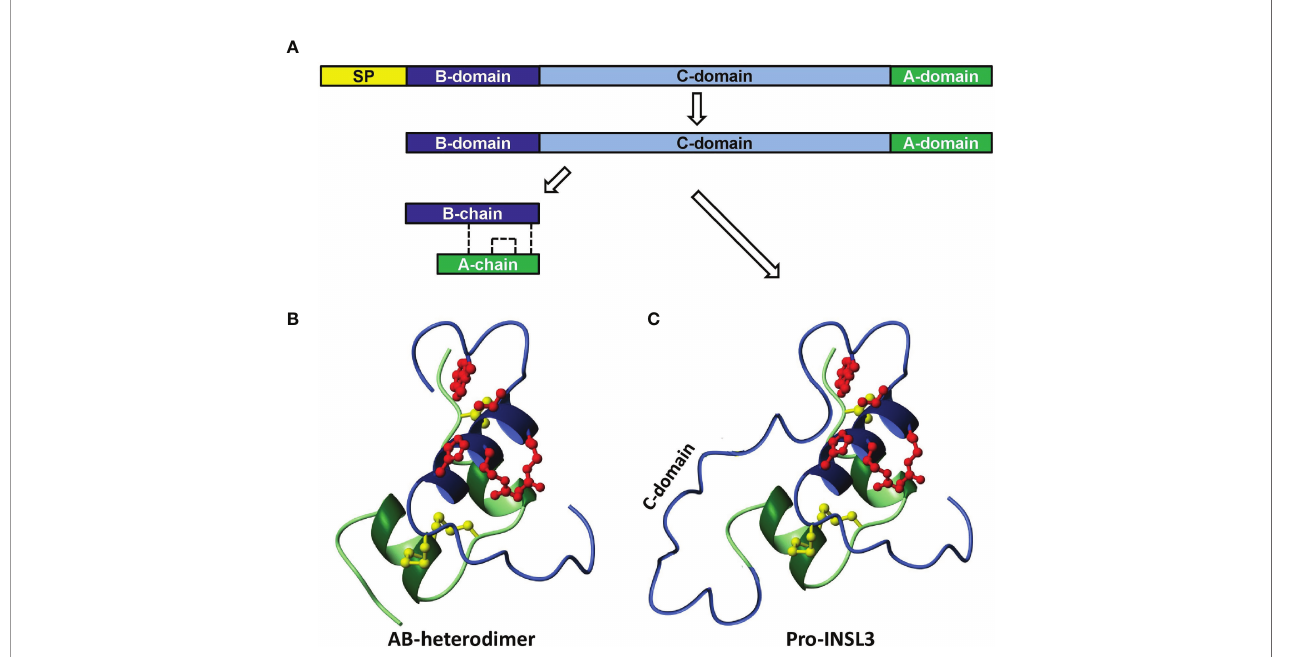
FIGURE 1 | Scheme to illustrate the synthesis and processing of INSL3 from its preliminary precursor form (A , prepro-INSL3 ) via a possibly secreted pro-form (A, C , pro-INSL3 ) , to give rise to the fi nal A-B heterodimer (B) . SP, signal peptide. The sulfhydryl bridges formed by cysteine residues are shown as dashed lines (A) or as yellow molecular structures (B, C) [reproduced from